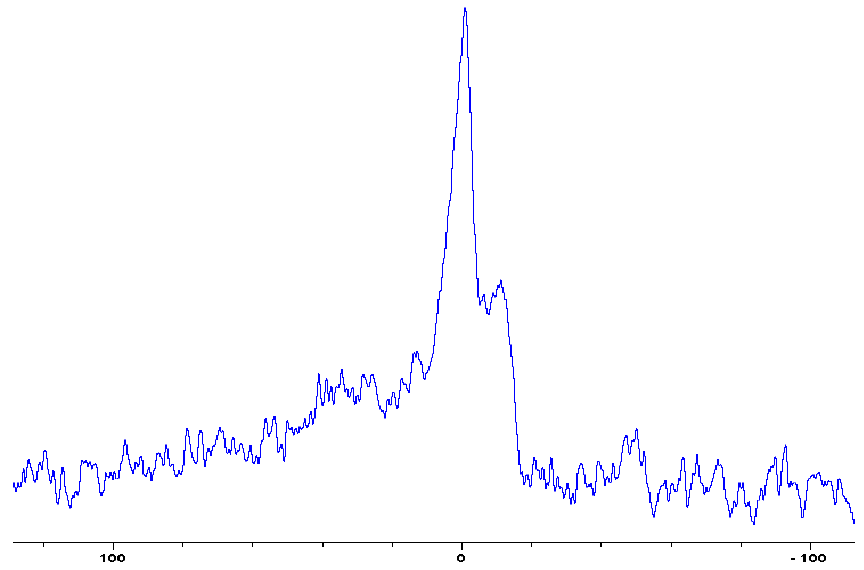
Figure 9. Solid-state 31 P-NMR spectrum of char obtained from fish gelatin + diethylbenzylphosphonate (DEBP) (the abscissa denotes the chemical shift values, δ , in ppm and the ordinate corresponds to the signal intensity in arbitrary units). Table 2. Chemical shift values ( ∂ in ppm) of P nucleus in the additives and in the char residue. ∂ Value for 31 P of the Additives * Sl. No. Additive (Solution-State)